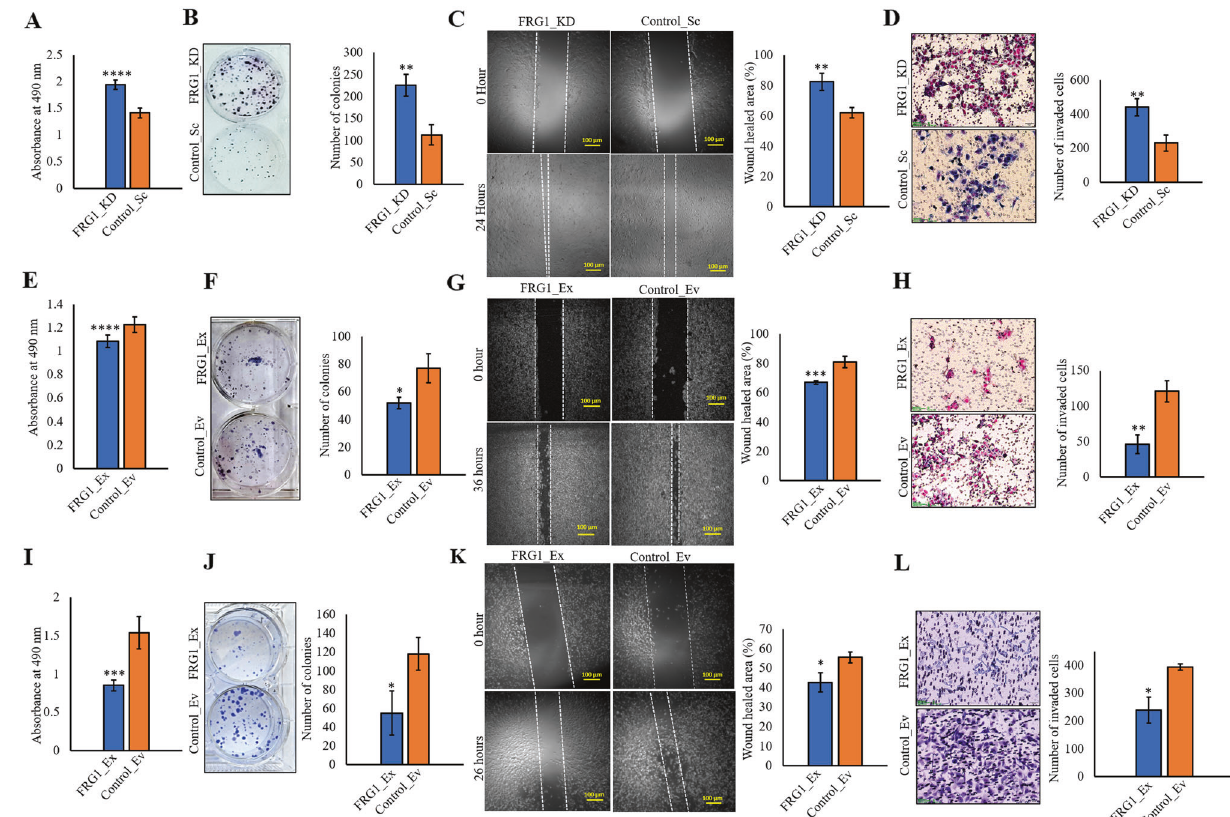
Fig. 1 Effect of FRG1 alteration on tumorigenic properties of breast cancer cells of different molecular subtypes. The levels of FRG1 were modulated in two breast cancer cell lines of different molecular subtypes and subjected to various cell-based assays; A , B Representative images of MTS assay ( A ) and colony formation assay ( B ) showing the difference in proliferative property of MCF7 cells due to FRG1 knockdown (FRG1_KD vs. Control_Sc). OD values were taken at 490 nm at 24 h. Bar diagrams show the difference between the two groups. C Representative images of scratch wound-healing assay in MCF7 cells with depleted FRG1 (FRG1_KD) and corresponding control (Control_Sc). The bar graph depicts the difference in the percentage of wound closure between the two groups. Scale bar, 100 μ m. D Representative images of matrigel transwell invasion assay in MCF7 cells with reduced FRG1 level (FRG1_KD) and respective control (Control_Sc). The bar graph depicts the difference in the number of invaded cells between the two groups. Scale bar, 50 μ m. E , F Representative images of MTS assay ( E ) and colony formation assay ( F ) in MCF7 cells with an elevated level of FRG1 (MCF7_Ex) and control (Control_Ev). Bar graph showing the difference between the two groups. G Representative images of scratch wound-healing assay in MCF7_Ex and Control_Ev. Bar graph showing the difference in wound closure between the two groups. Scale bar, 100 μ m. H Representative images of matrigel transwell invasion assay in MCF7_Ex and Control_Ev. The difference in invaded cells between the two groups is shown in the bar graph. Scale bar, 50 μ m. I , J Representative images of MTS assay ( I ) and colony formation assay ( J ) in MDA-MB-231 cells with elevated expression of FRG1 (FRG1_Ex) and their control (Control_Ev). Bar graphs indicate the difference between the two groups. K Representative images showing scratch wound-healing assay performed in MDA-MB-231_FRG1_Ex and Control_Ev. The bar diagram shows the difference in wound healing percentage between the two groups. Scale bar, 100 μ m. L Representative images of transwell invasion assay, performed in MDA-MB-231_Ex and Control_Ev. The bar diagram shows the difference in invaded cells between the FRG1_Ex and Control_Ev. Scale bar, 50 μ m. Experiments were performed in triplicate, two-tailed unpaired student ’ s t-test was used to compare the two groups ’ differences. Results are presented as mean ± SD. * P ≤ 0.05; ** P ≤ 0.01; *** P ≤ 0.001; **** P ≤